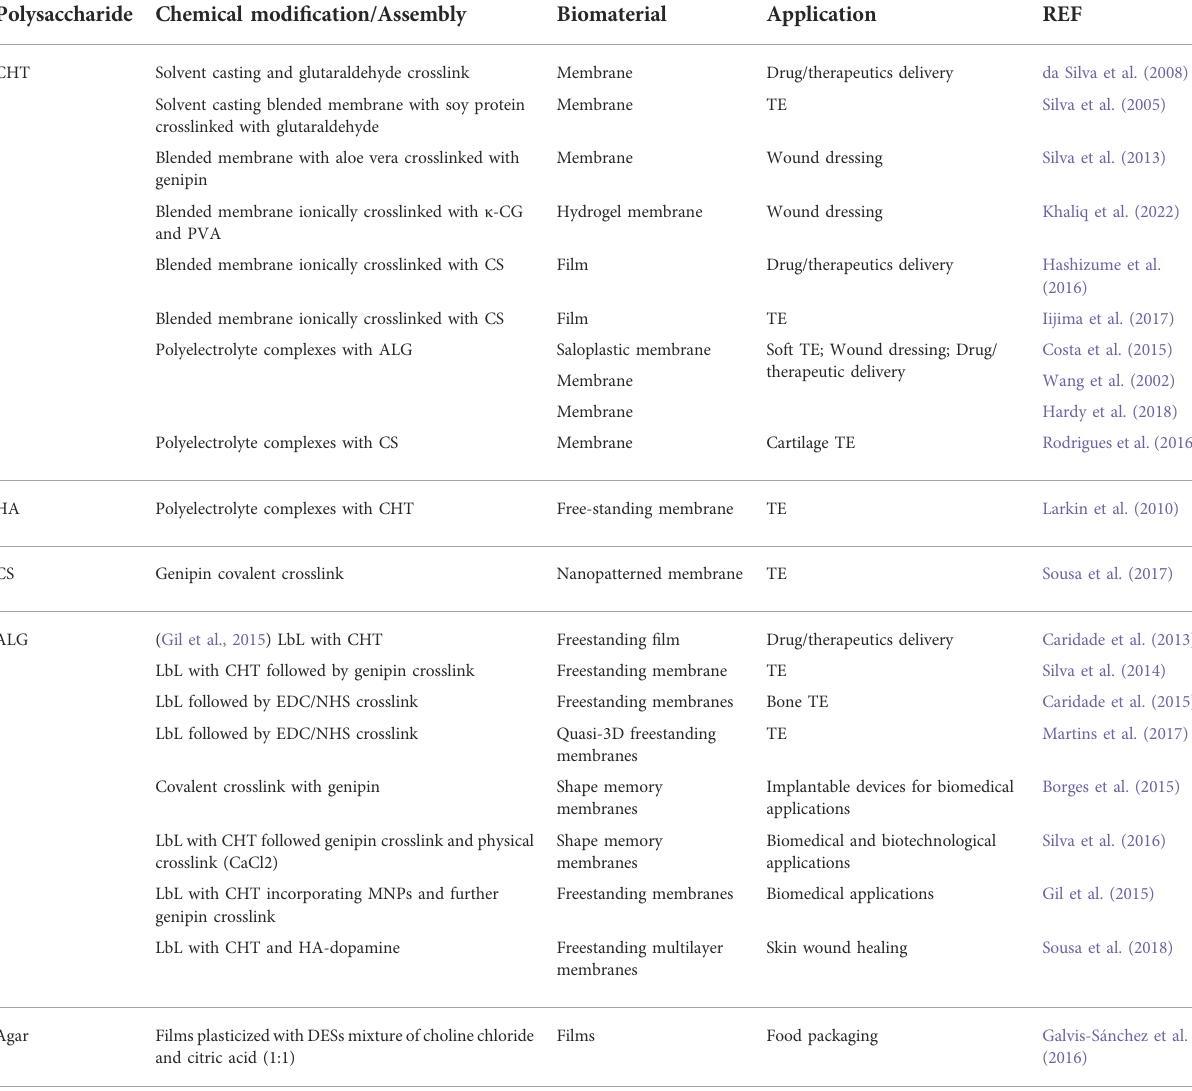
TABLE 4 Membrane-shaped biomaterials based on marine-derived polysaccharides for biomedical applications. Polysaccharide Chemical modi fi